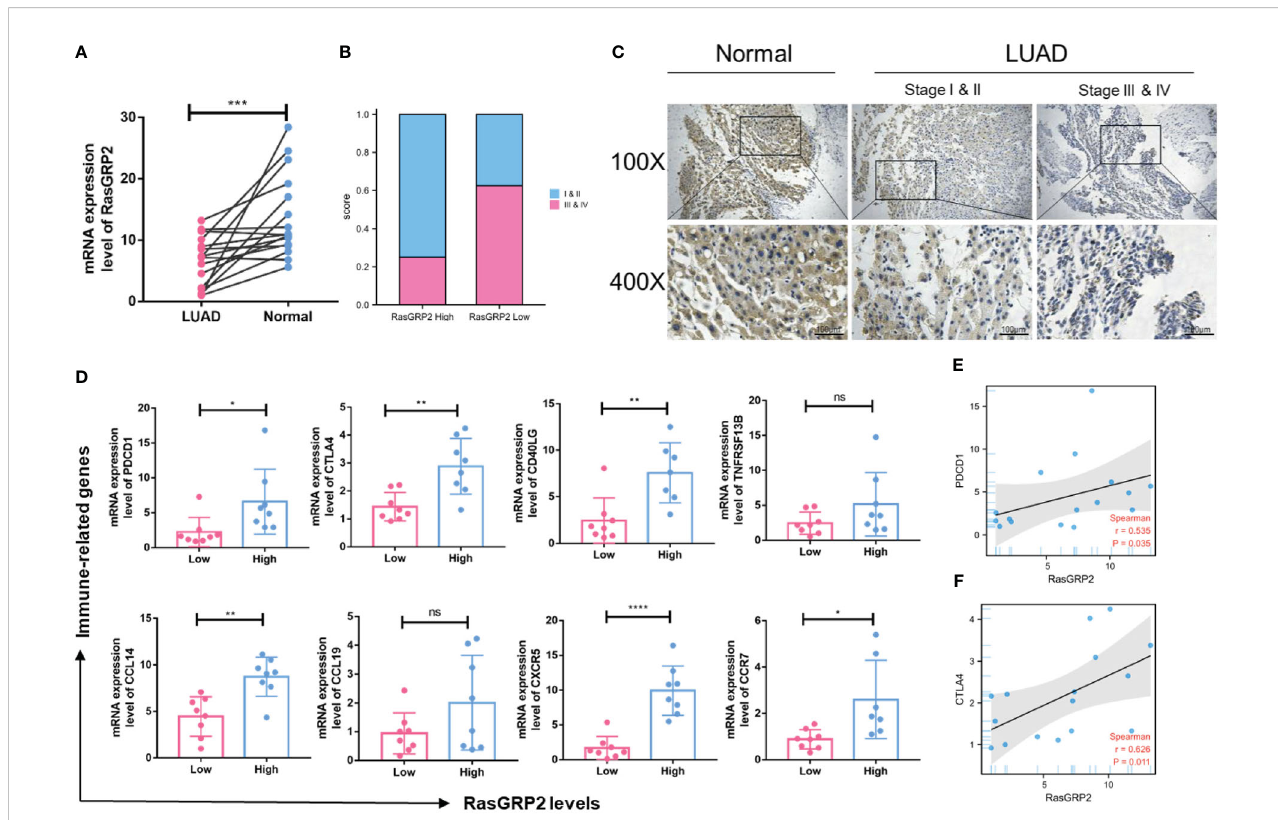
FIGURE 11 Validation of the expression level of RASGRP2 and immune-related molecular in fi ltration in a real-world cohort. (A) mRNA expression levels of RASGRP2. (B, C) The expression level of RASGRP2 correlated with the pathological stages. (D) The expression levels of PDCD1, CTLA4, CD40LG, CCL14, CXCR5 and CCR7 were higher in the high-RASGRP2 expression group in the real-world cohort. (E, F) RASGRP2 was positively correlated with PDCD1 and CTLA4 in the real-world cohort. ****P < 0.0001, ***P < 0.001, **P < 0.01, *P < 0.05, ns, no signi fi